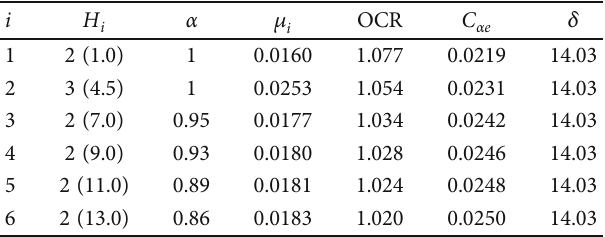
Table 3: The calculation results of